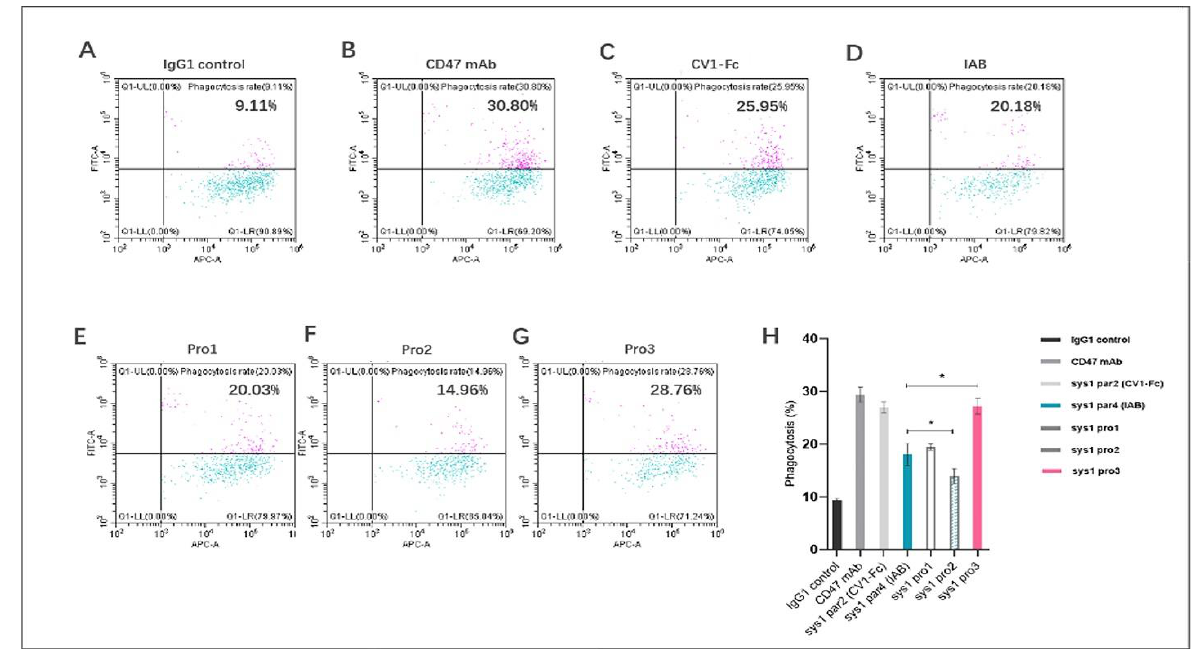
Figure 7. Novel reconstructed proteins induced human macrophages to phagocytize MDA-MB-231 tumor cells. The proportion of macrophages that engulfed tumor cells was measured by flow cytometry as a proportion of CFSE+CD11b+ cells. ( A ) Isotype IgG1; ( B ) positive control anti-CD47 mAb; ( C ) structure control CV1-Fc; ( D ) prototype IAI ( E ) Pro1; ( F ) Pro2; ( G ) Pro3. ( H ) The results are presented as mean ± standard deviation (SD), where * p < 0.05 is indicative of statistical difference.